Question: According to the figure, is the described quantity increasing or decreasing?
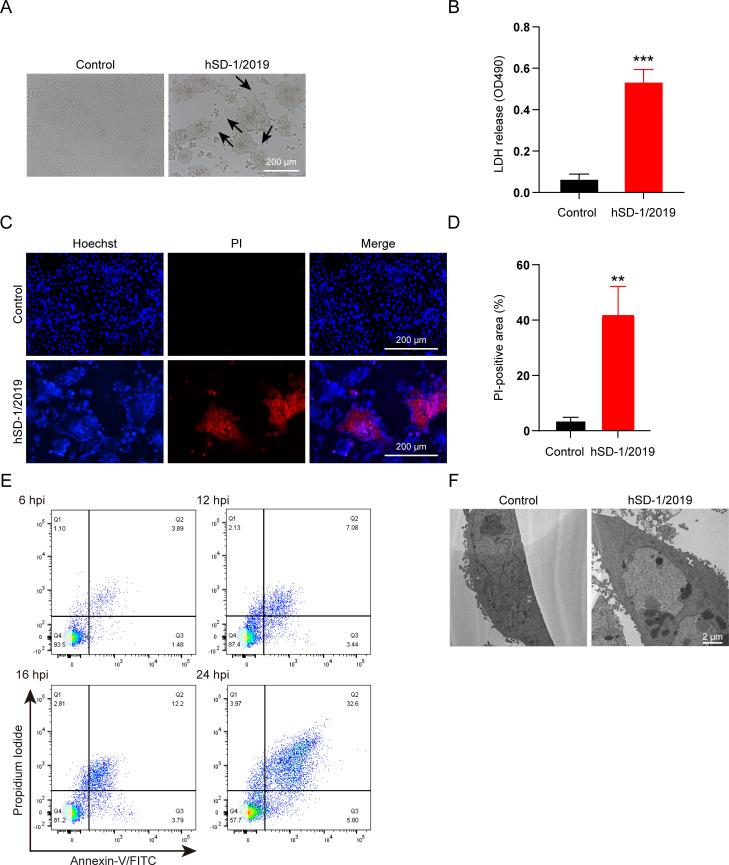
Answer: increasing